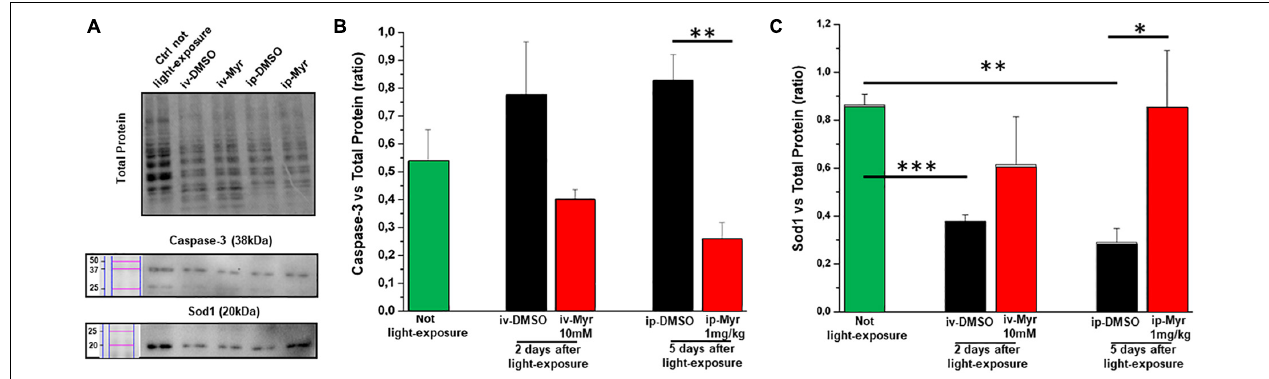
FIGURE 6 | Systemic Myriocin treatment increases the level of Sod1 protein. (A) Representative example of WB experiment of caspase-3 and Sod-1 content. (B) Quantification by optical densitometry of caspase-3 levels in Tvrm4 animals treated with Myriocin (red bar) or with vehicle (black bar) compared to the level in non-exposed mice (green bar). The bar graph shows that the levels of the pro-apoptotic marker caspase-3 are reduced in the group of animals treated with Myriocin. (C) Quantification by optical densitometry of Sod1 levels in Tvrm4 animals not light-induced (green bar), treated with vehicle (black bar), or treated with Myriocin (red bar). The bar graph shows that the levels of the anti-oxidant enzyme Sod1 are significantly increased in the group of mice treated with Myriocin, with respect to both the group of non-degenerate control animals and the group of mice treated with the vehicle alone. Values are shown as mean ± SEM ( n = 4, for each analyzed group); ∗ p ≤ 0.05, ** p ≤ 0.01, *** p ≤ 0.001. (B) Representative example of WB